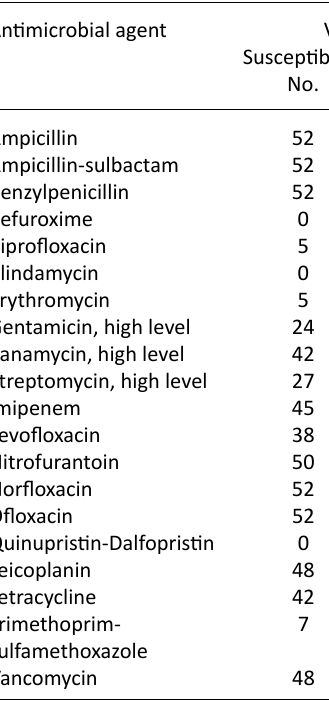
Ampicillin-sulbactam